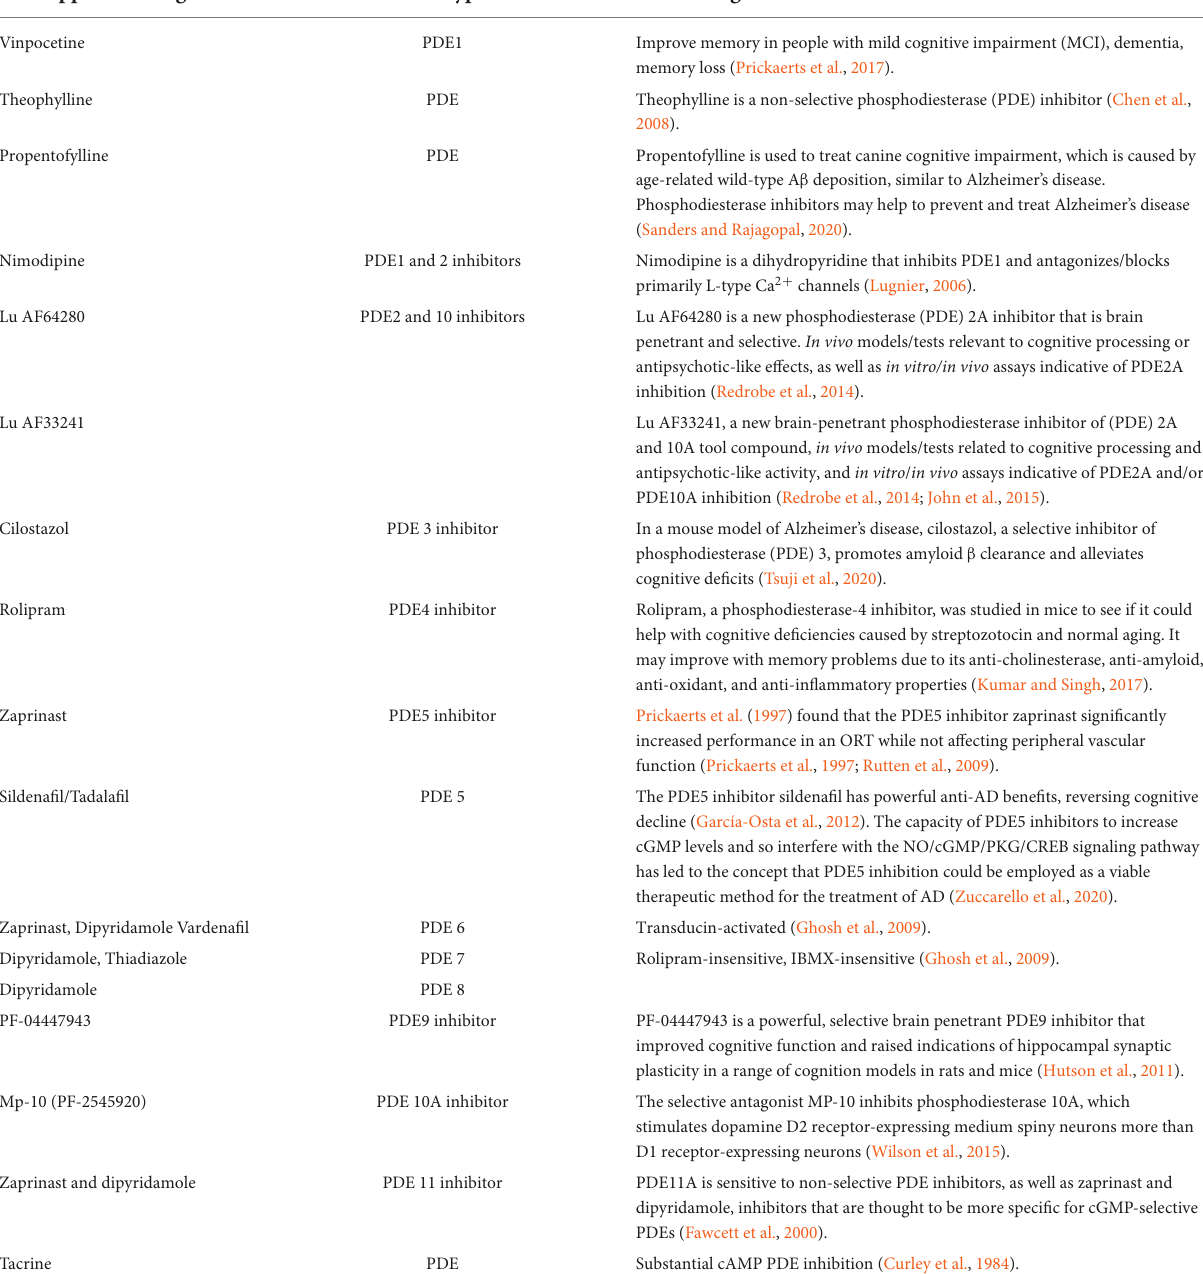
TABLE 4 List of synthetic drugs for PDE inhibitors and their impact on clinical significance with a focus on Alzheimer’s disease. FDA approved